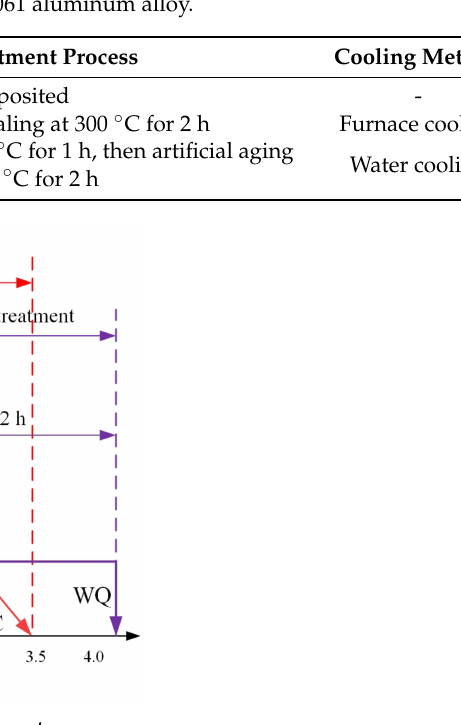
Figure 4. Schematic diagram of the heat-treatment